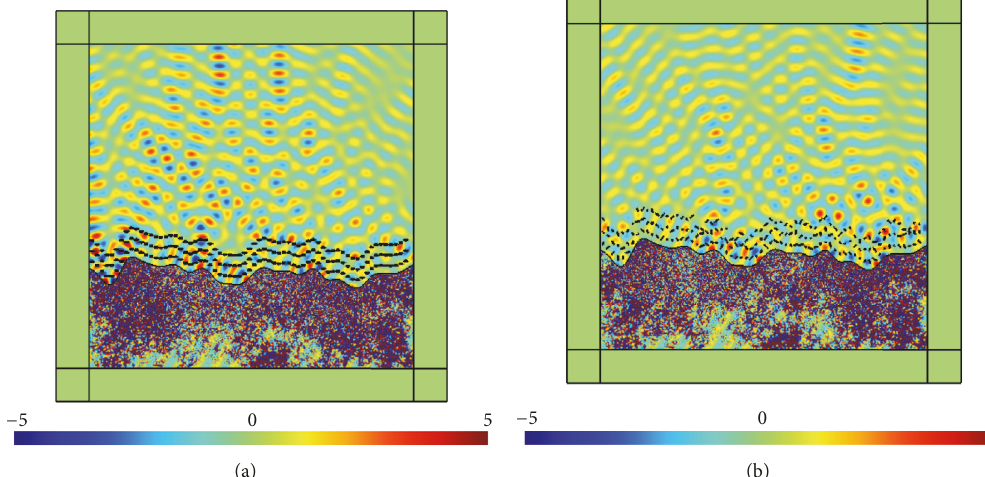
Figure 3: Near scattering field from the multilayers vegetation. (a) Uniformly distributed vegetation. (b) Randomly distributed vegetation.